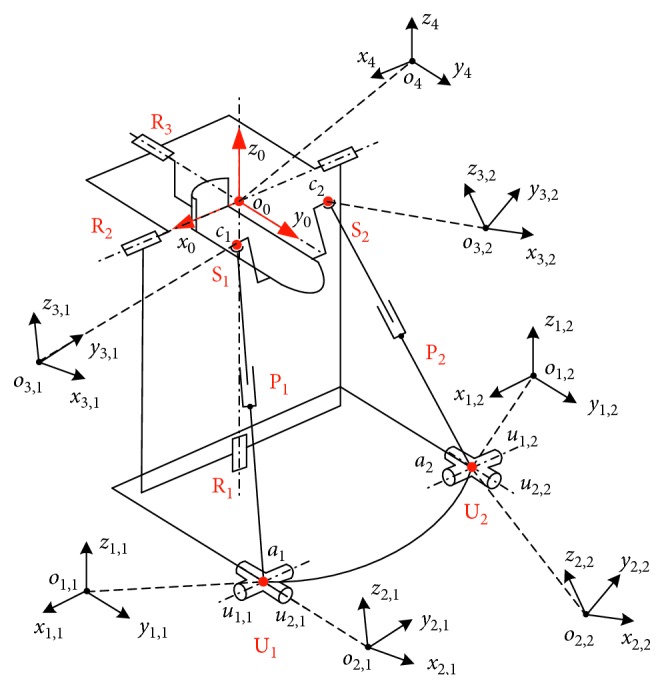
Schematic diagram of PARR.